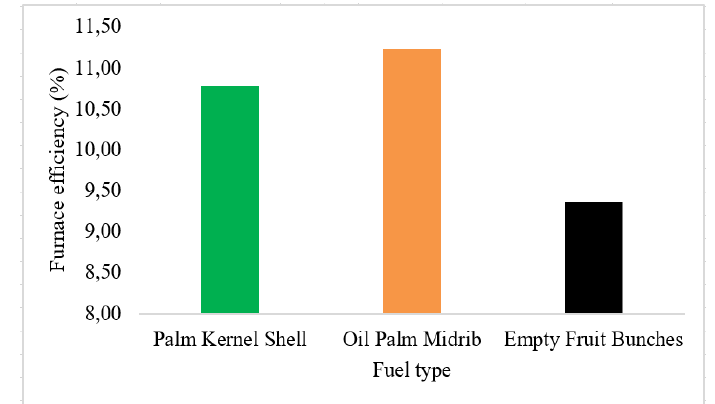
Figure 10. Furnace efficiency in the FBC for different fuels.